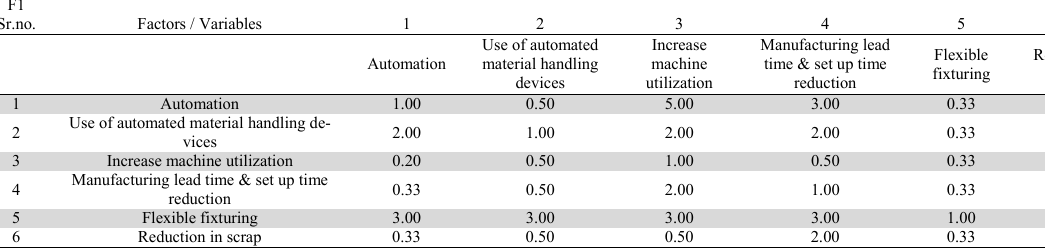
Alternative selection attribute matrix (For Alternative